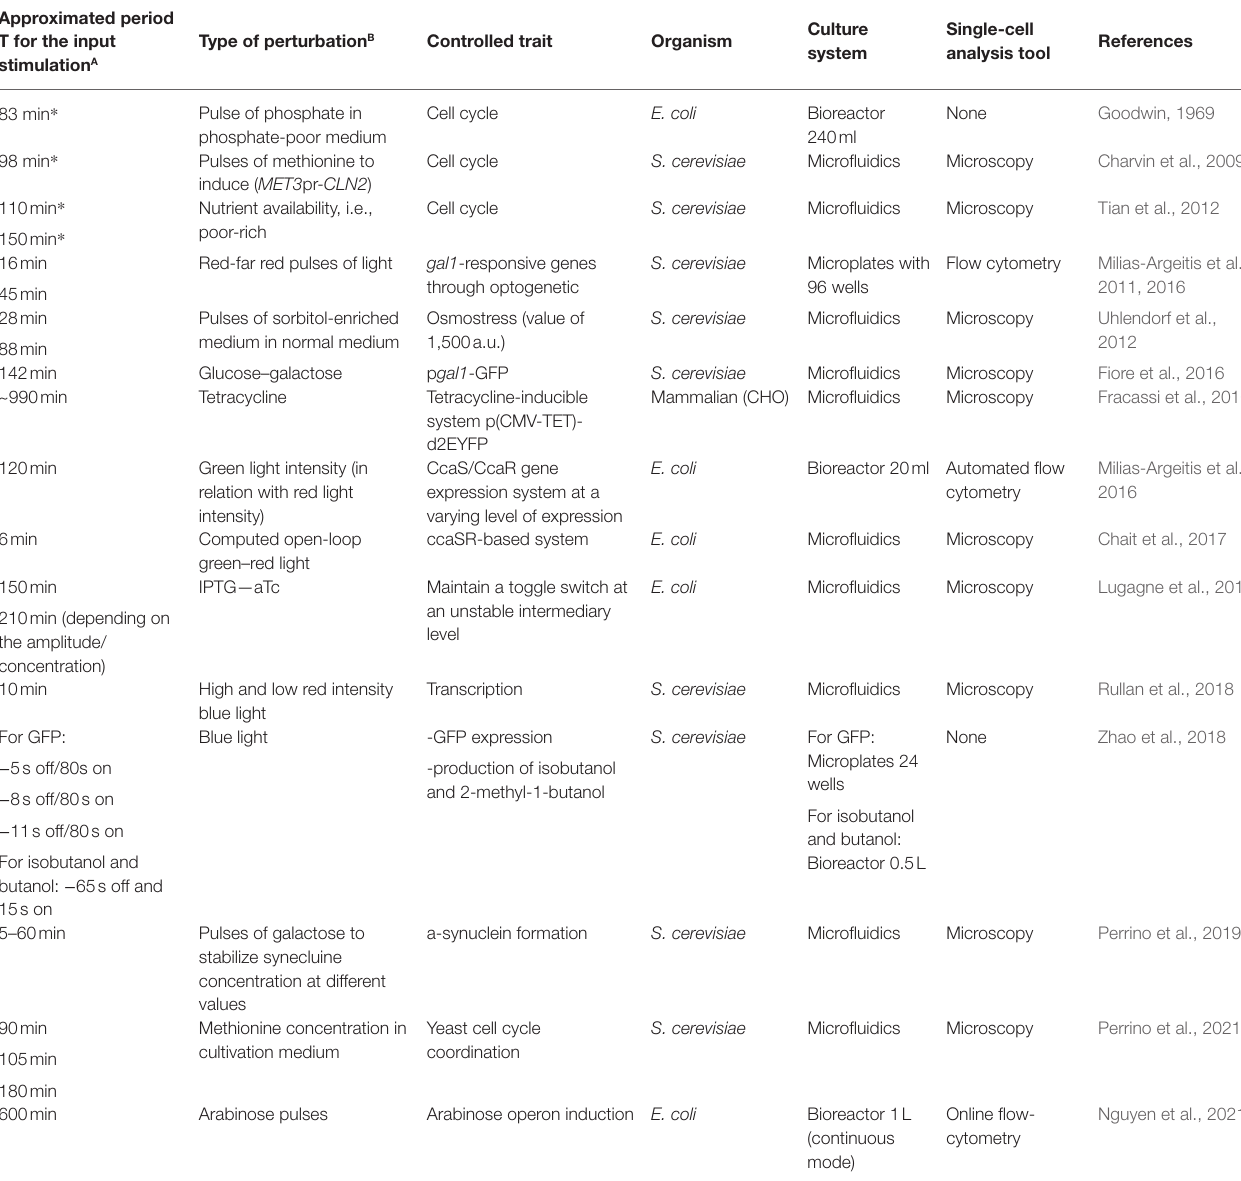
TABLE 1 | Range of environmental stimuli used for controlling gene expression in cell population and range of periodic signal associated with these environmental perturbations. Approximated period T for the